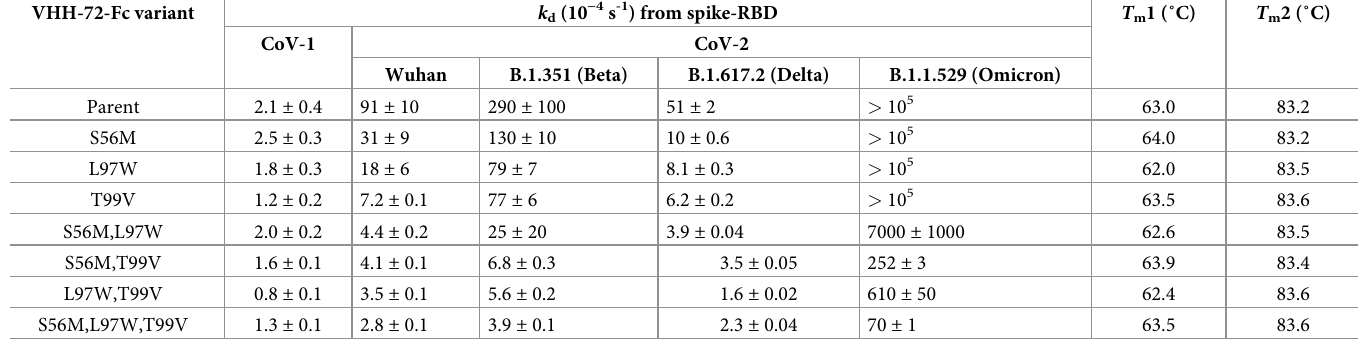
Table 2. Binding and stability of single-mutation hits and multiple mutants of VHH-72-Fc. VHH-72-Fc